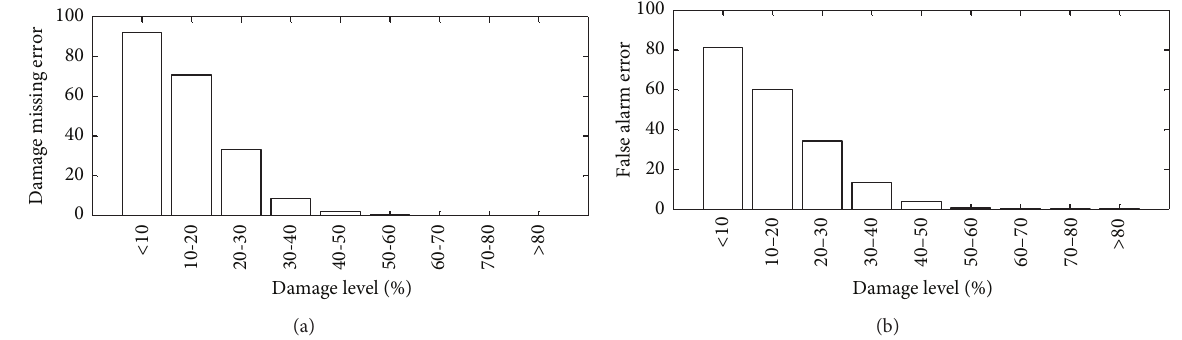
Figure 13: Damage missing error (DME) and false alarm error (FAE) for different damage levels.